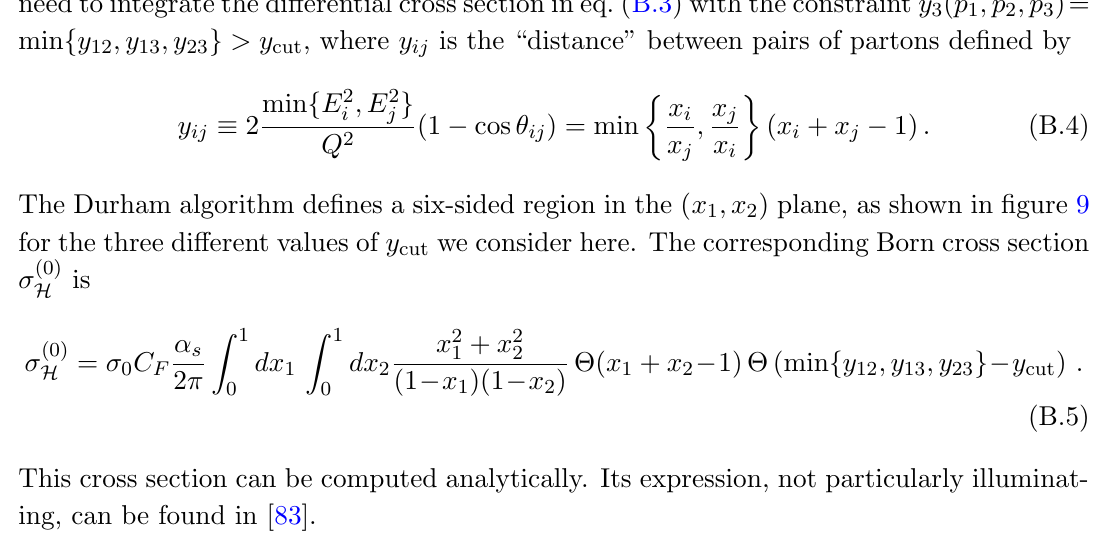
( y ) with the Durham algorithm [60] we 0 cut